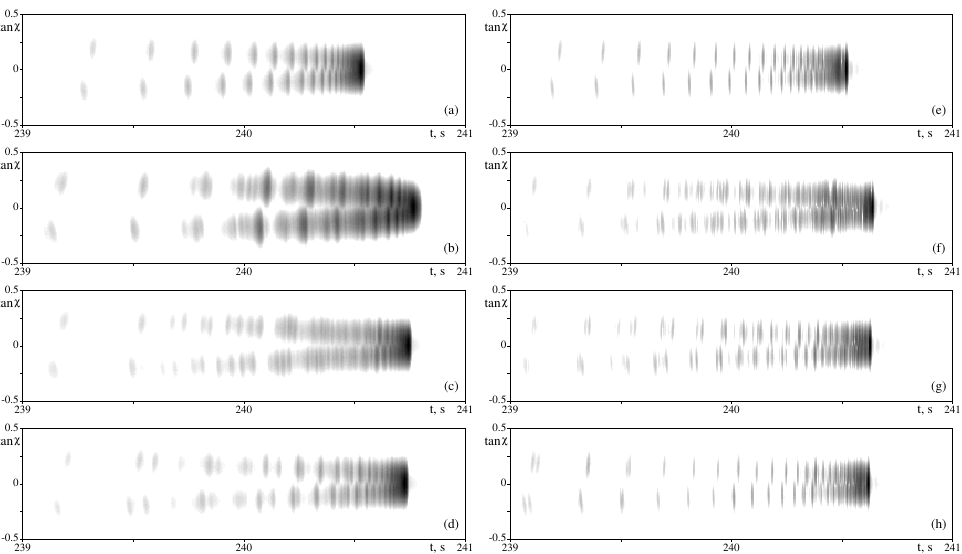
Figure 2. Logarithm of the Husimi function in the plane, where the horizontal coordinate is the arrival time, and the vertical coordinate is the tangent of the arrival angle. Figures ( a – d ) correspond to aver- aging over 100 realizations of internal waves. Figures ( e – h ) correspond to the model of a waveguide without internal waves. The vertical coarse-graining scale ∆ z is 10 m. Panels ( a – e )—waveguide with- out the eddy, panels ( b – f )—the eddy core at z e = 600 m, panels ( c – g )—the eddy core at z e = 1000 m, panels ( d – h )—the eddy core at z e = 1500